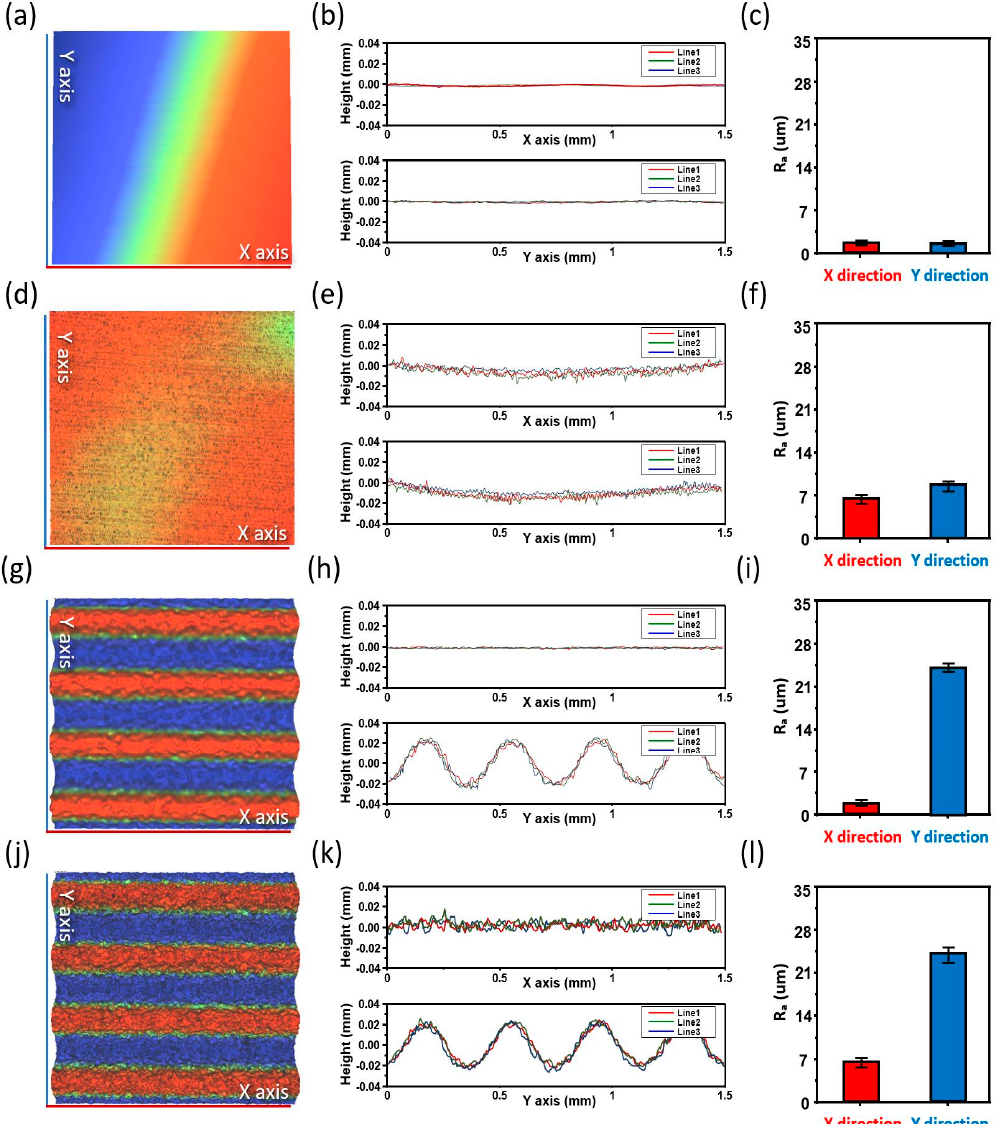
Figure 4. Three-dimensional (3D) image: ( a , d , g , j ); line-scan profiles in the x and y directions: ( b , e , h , k ); surface-roughness averages (R a ): ( c , f , i , l ). form above the first row, bare Cu current collector, Cu current collector after the laser ablation (laser-ablated Cu current collector), Cu current collector after the imprinting metal mold, and Cu current collector after the laser ablation + imprinting sequentially.